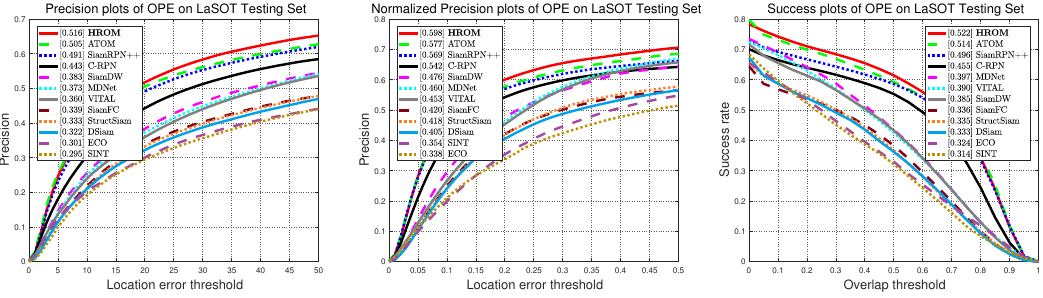
Precision plots of OPE on LaSOT Testing Set Normalized